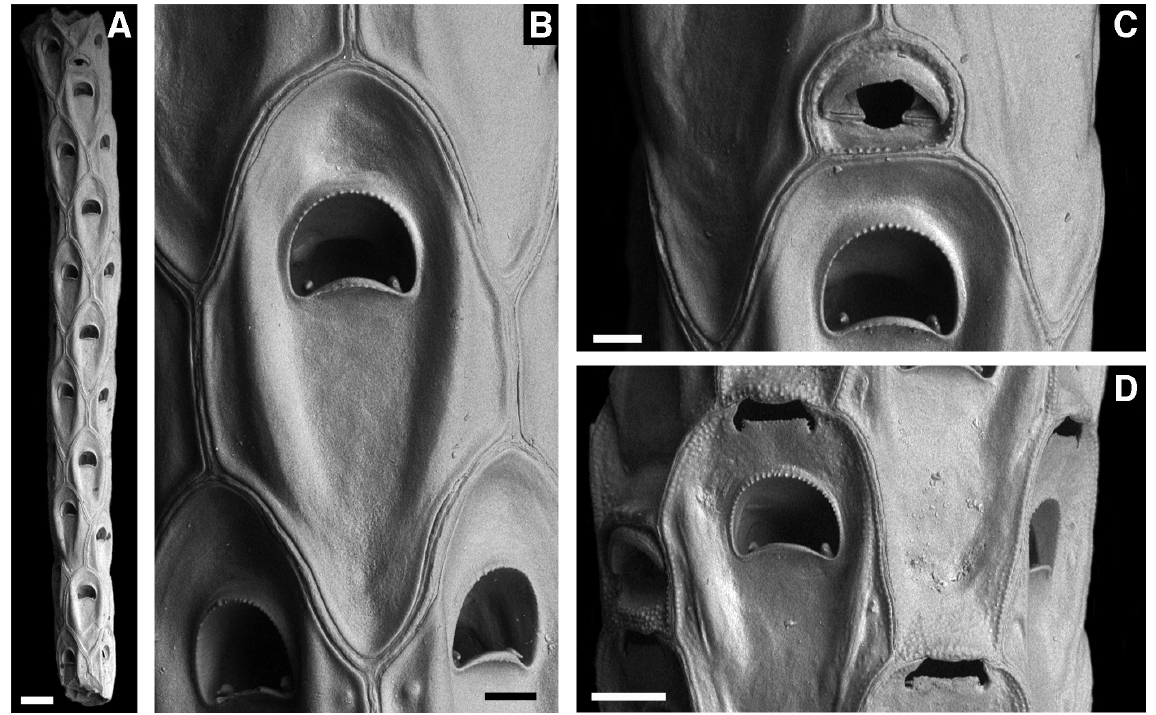
Fig. 2. Cellaria harmelini d’Hondt, 1973 (MnHn 6902, paralectotype). A . Overview of an infertile internode with a distal avicularium. B . Close-up of an autozooecium. C . An avicularium situated distal to an autozooecium. D . Ovicellate zooecia, one with a distal avicularium at left. Scale bars: A = 200 µm; B, C = 50 µm; D = 100